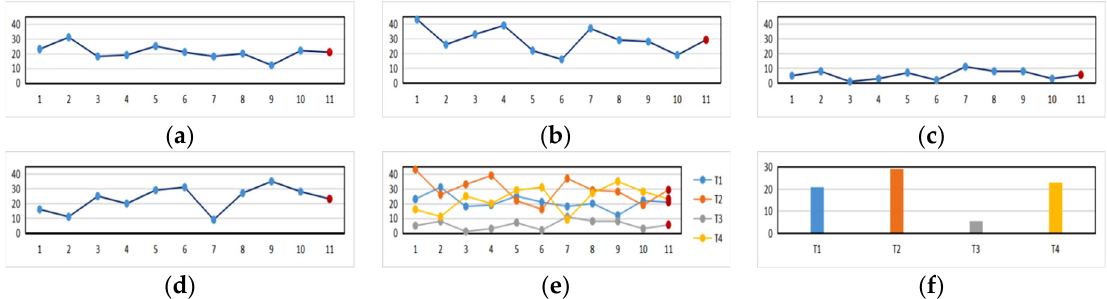
Figure 9. The fluctuating curves of the tourist attraction classification label word frequency and a comparison of the tourist